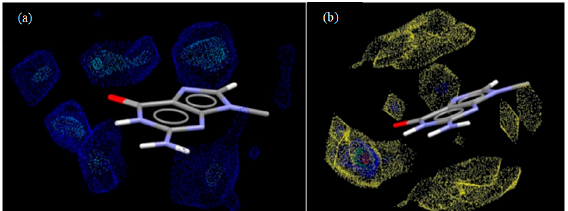
Figure 4. IsoStar contour plot with guanine as the central group having ( a ) nitrogen and oxygen as the contact groups (internal scaling: level 25—dark blue, level 50—lighter blue, level 75—turquoise) and ( b ) only carbon as the contact group (internal scaling: Level 10—Yellow, Level 25—Blue, Level 50—Green, Level 75—Red). The contour plot in Figure 4b highlights the ability of carbon to act as a hydrogen bond donor, as well as the dominant presence of possible C–H ‧‧‧ π interactions or π ‧‧‧ π stacking, created due to the delocalized electron density in the aromatic guanine ring sys- tem. Other contour plots were constructed using an aliphatic ether as hydrogen bond ac- ceptor and hydroxyl group as the central group. The distributions of the resultant hits of both plots were as expected (Please refer to Supplementary Materials).